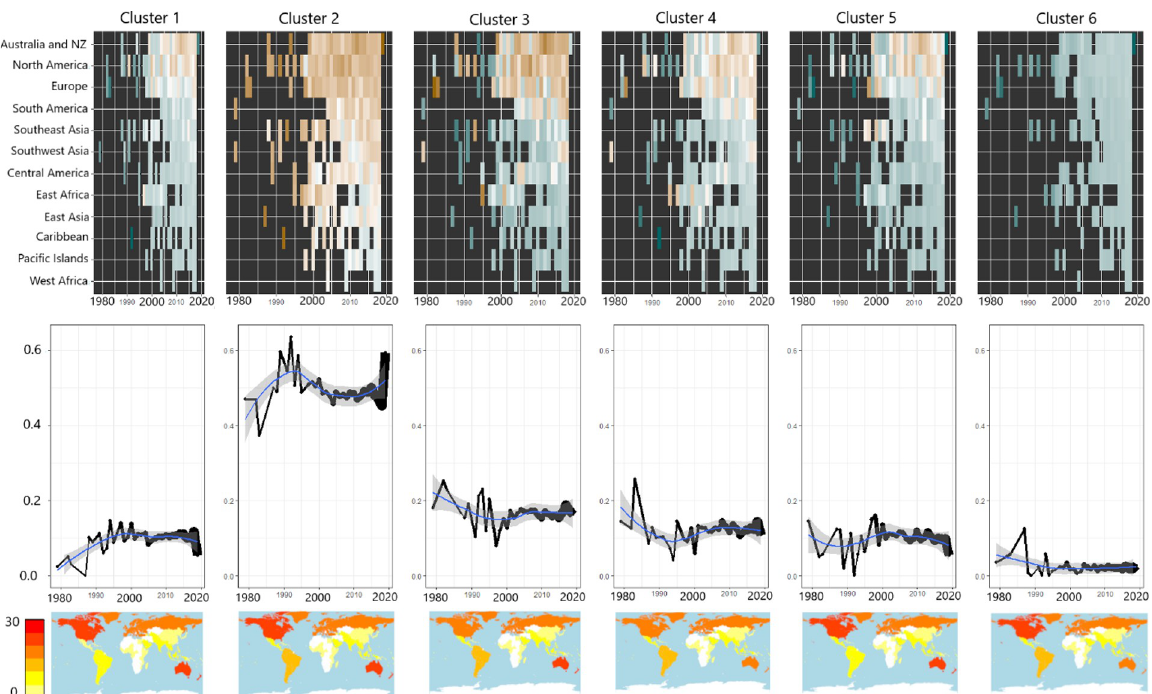
Fig 6. This figure has three parts. Top: Trajectories of the six terminology clusters identified from abstracts’ indicator words (1–6 Table 5 above) through space and time, as displayed through heat-maps of deviations from the occurrences of the cluster that would be expected if indicator words were uniformly distributed across clusters and regions in each year. Positive anomalies show increasing shades of brown, and negative anomalies turquoise (White = as expected if abstracts’ indicator words were even across clusters, space and time; Brown = more important; Turquoise = Less important; Black = No publication for that year and region). Mid: Time series of the contributions of each terminology to the total number of indicator words produced that year; increasing line widths represent the growing number of total publications (and hence: indicator words) through time. Bottom: Percentage contribution of each World Bank region to each terminology, averaged over time. White areas are countries with no first author publication.